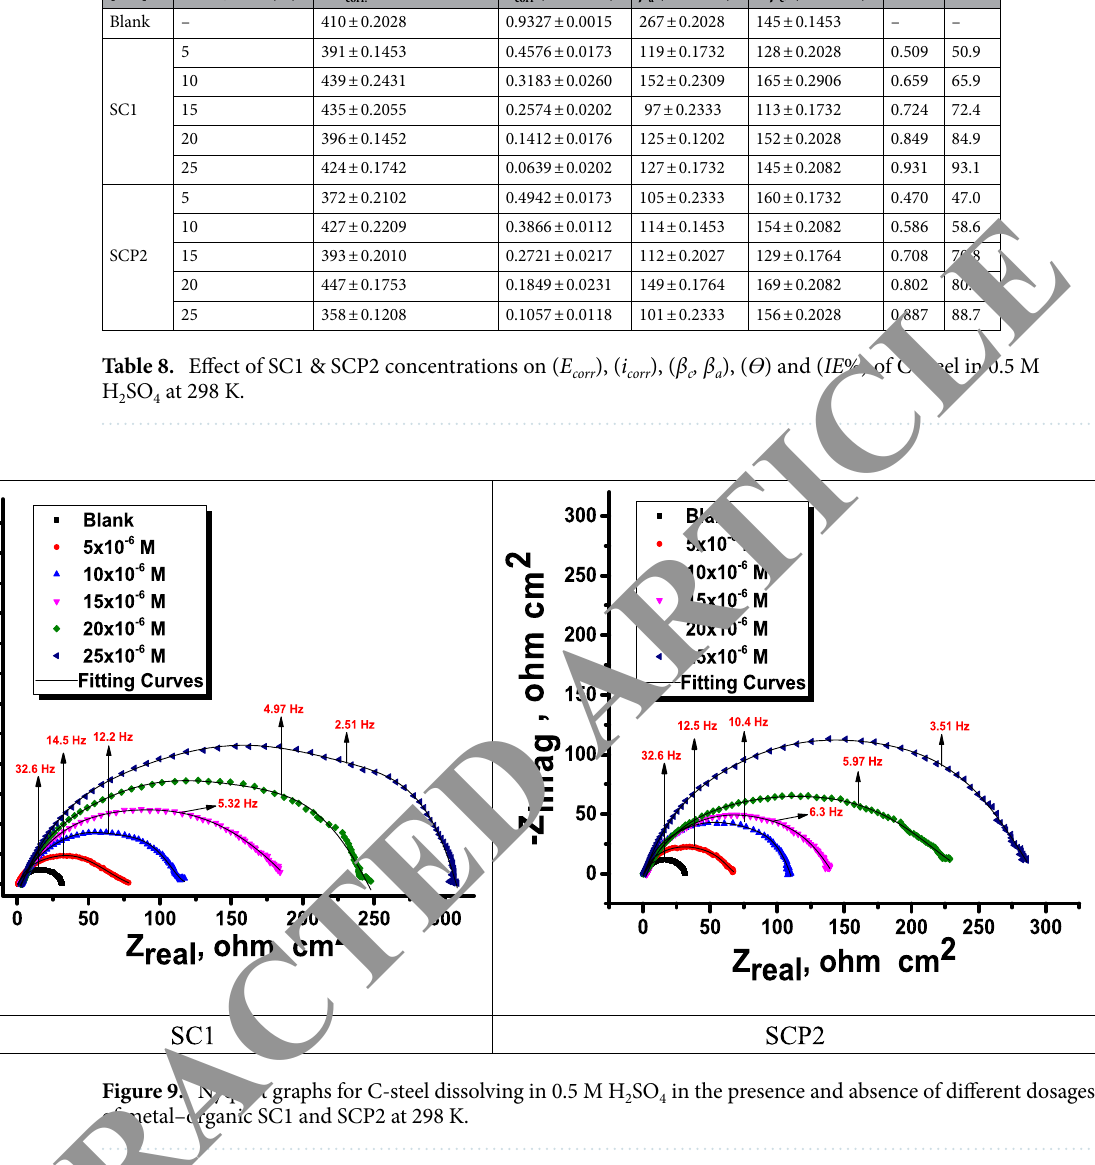
Figure 9. Nyquist graphs for C-steel dissolving in 0.5 M H 2 SO 4 in the presence and absence of different dosages of metal–organic SC1 and SCP2 at 298